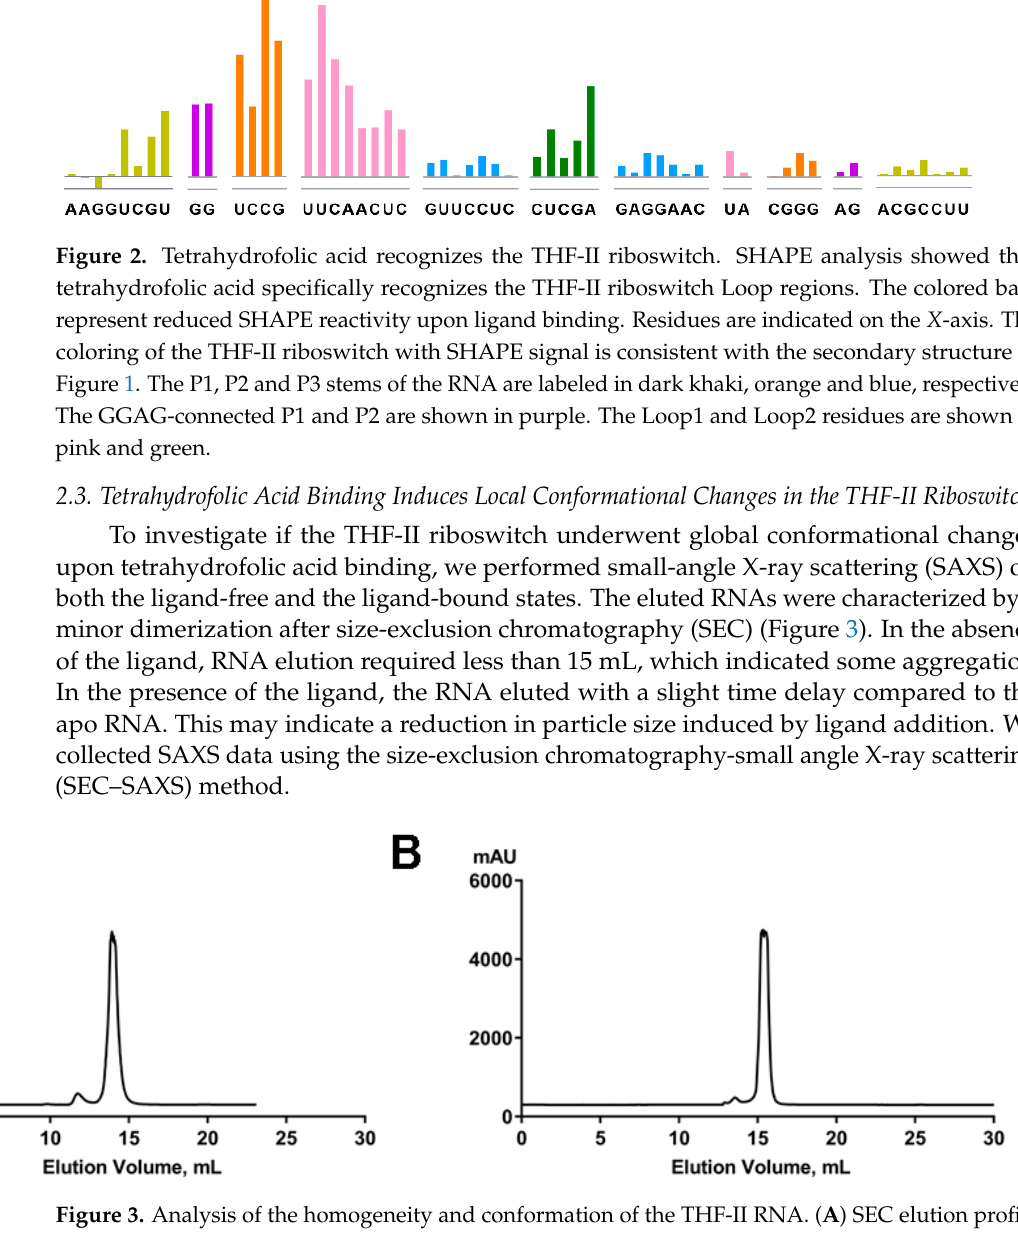
Figure 3. Analysis of the homogeneity and conformation of the THF − II RNA. ( A ) SEC elution profile of the THF − II riboswitch in the absence of the ligand. RNA concentration: 10 mg/mL. ( B ) SEC elution profile of the THF − II riboswitch in the presence of the ligand. RNA concentration: 10 mg/mL. Ver- tical axes for ( A ), ( B ) are in mAU at 254 nm.